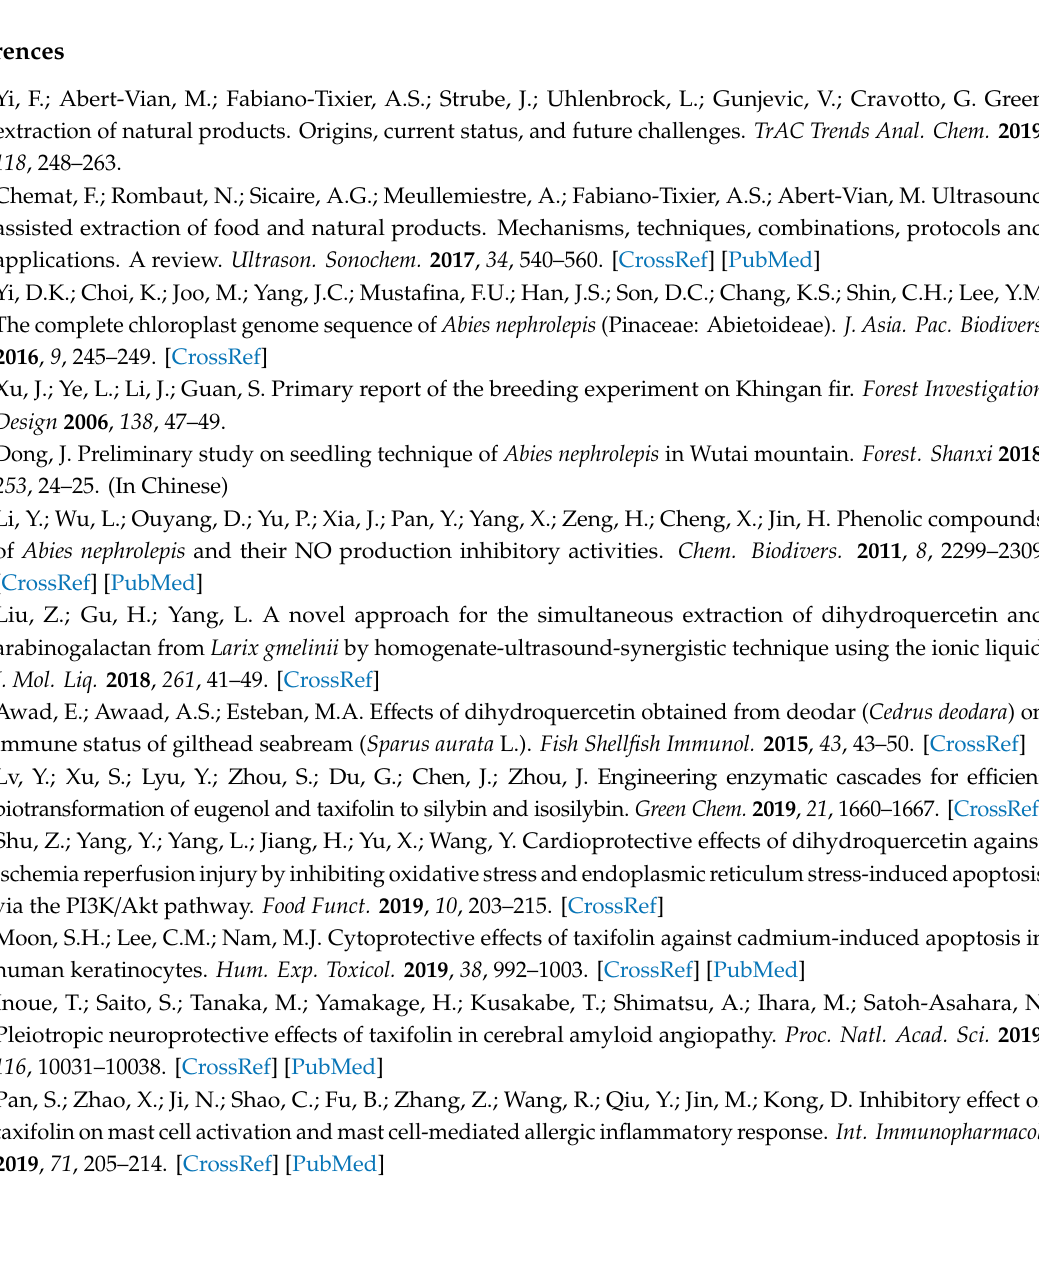
Table S1: Box-Behnken design (BBD) with experimental value for total yield of the three